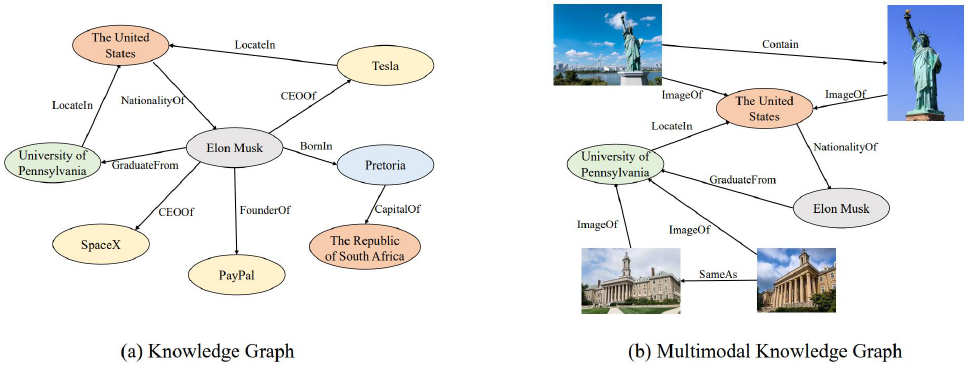
Figure 1. An example of a knowledge graph and a multimodal knowledge